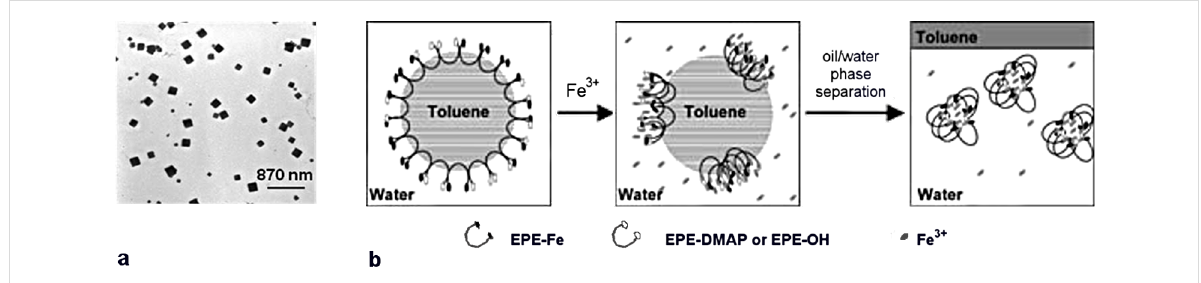
Figure 9: a: TEM micrograph of the cubic structures, b: proposed mechanism for the production of the nanocubes. The localized coordination poly- merization is thought to destabilize the miniemulsion and nanocube growth is carried on in the aqueous phase (reproduced with permission from [136]. Copyright (2010) Wiley-VCH Verlag GmbH & Co,